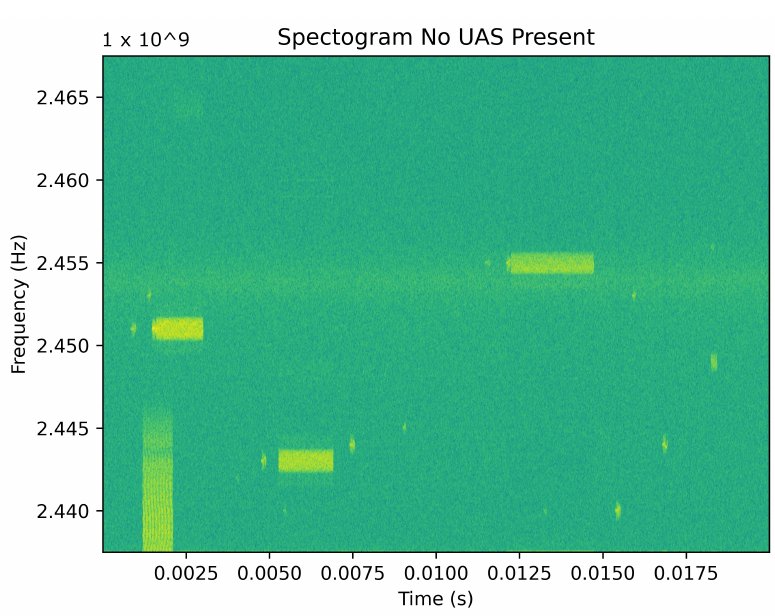
Figure 2. Spectrogram: No UAS present. Figure 3 shows the same data represented in the frequency domain through a